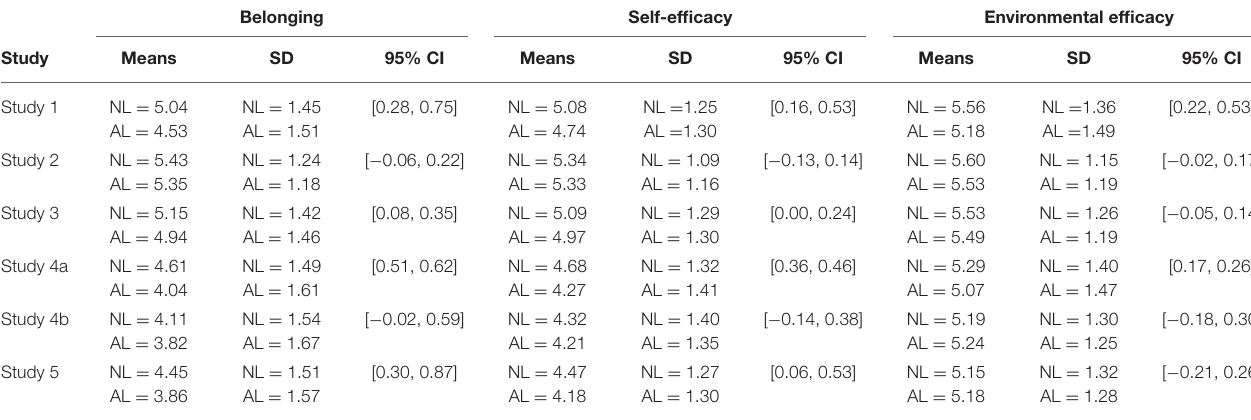
TABLE 7 | Mean, standard deviation, and 95% CI scores obtained for light for all the studies. Belonging Self-efficacy Environmental